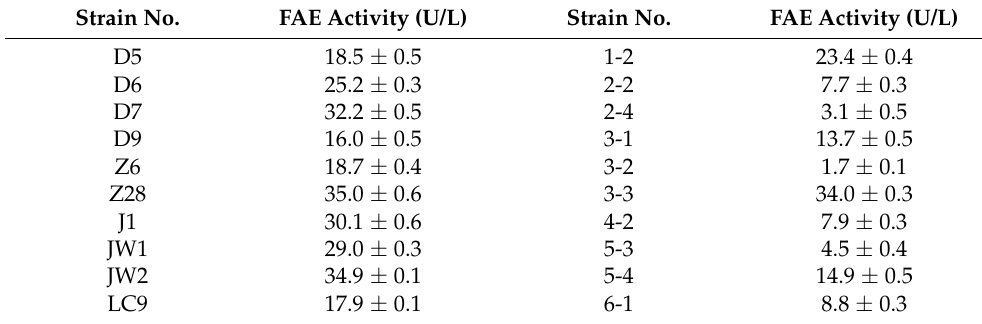
Table 2. FAE enzymatic assay of the strains. Strain